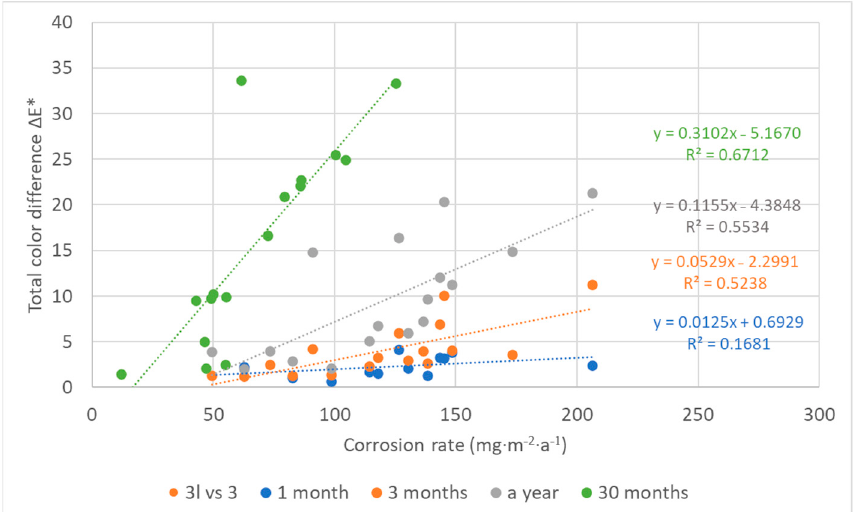
Figure 19. Comparison of corrosion rates of silver based on mass losses after 1-year exposure with total color changes after 1, 3, and 12 months, and mass losses after 30 months with color changes after the same time.